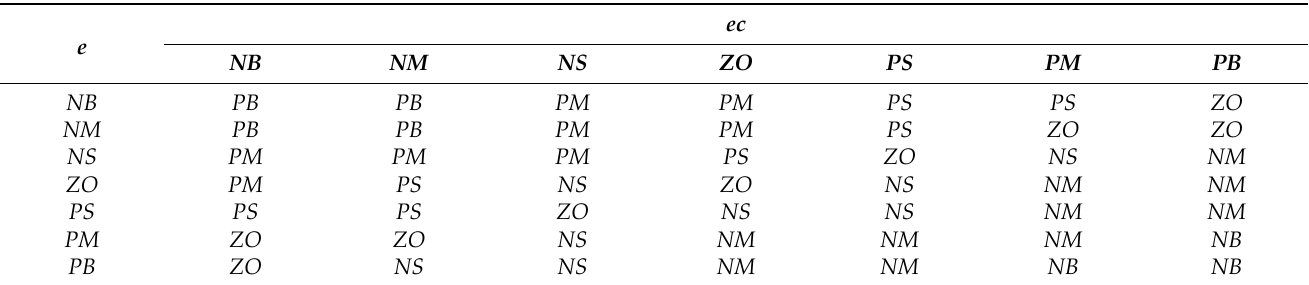
Table 2. Kp fuzzy control rules table.